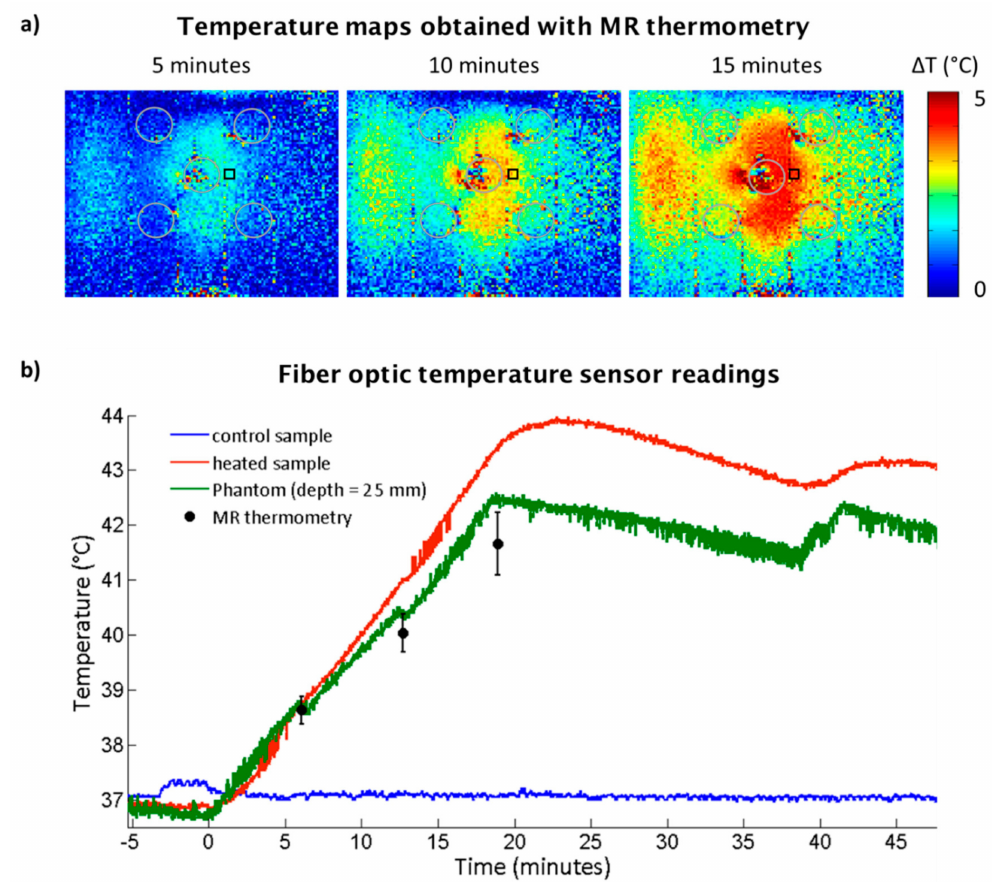
Figure 2. ( a ) Temperature distribution maps in the phantom at depth = 25 mm obtained with magnetic resonance (MR) thermometry and the bow tie dipole RF antenna. To guide the eye, the gray circles were inserted to mark the sample holders and the black rectangle marked the position of the fiber optic temperature sensor. ( b ) Temperature along time from the fiber optic temperature sensor readings in the controlled sample holder (blue line), in the heated sample holder (red line) and inside phantom (green line) next to the heated sample (black rectangle in ( a )), and temperature obtained by MR thermometry (black dot) at the position of the black